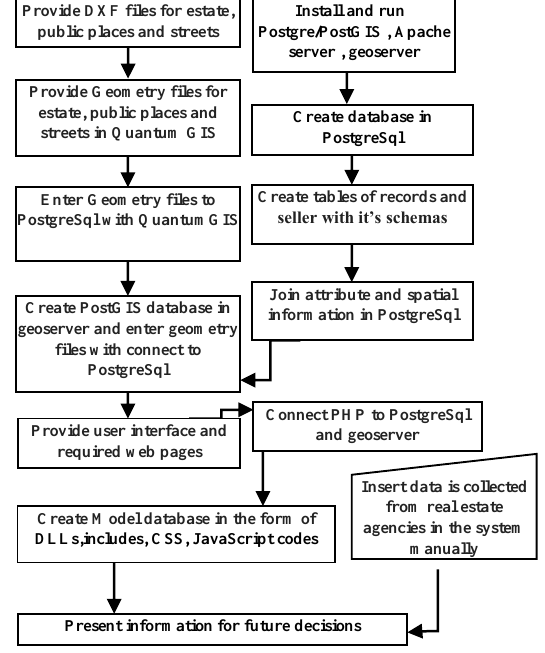
Present information for future figure 7. Overall process of real estate support system implementation